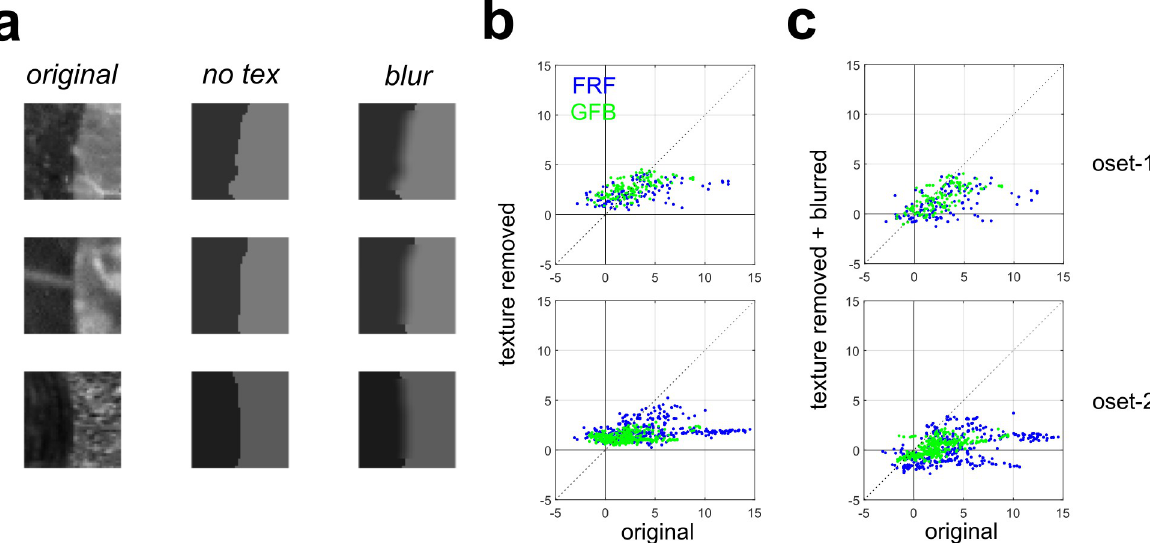
Fig 9. Effects of removing texture information from image patches on responses of the GFB and FRF models. ( a ) Left : Original occlusions. Middle : Averaging the pixel intensities on each side of the occlusion boundary removes texture information while leaving Michelson contrast unchanged (no tex). Right : Blurring the sharp edge created by texture removal (blur). ( b ) Log-odds ratio of being an occlusion for the original images ( horizontal axis ) versus the texture-removed images ( vertical axis ). We see images for which the model predicts a high occlusion probability experience a drastic decrease in occlusion probability when texture is removed. Top : oset-1 , Bottom : oset-2 . ( c ) Same as (b) but for blurred texture- removed